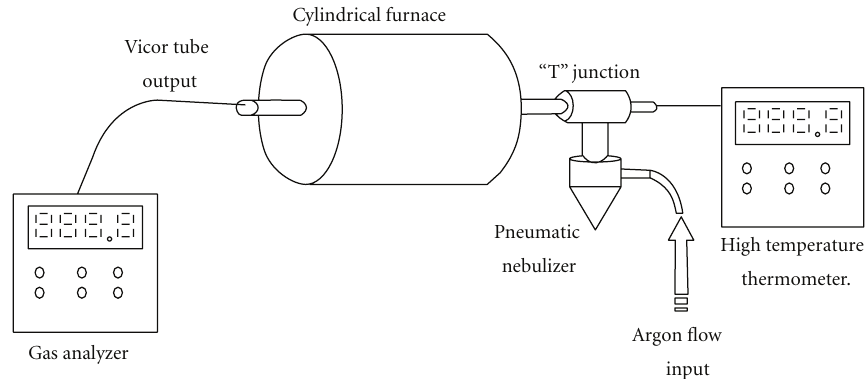
Figure 1: Spray pyrolysis system with a gas measurements equipment employed.